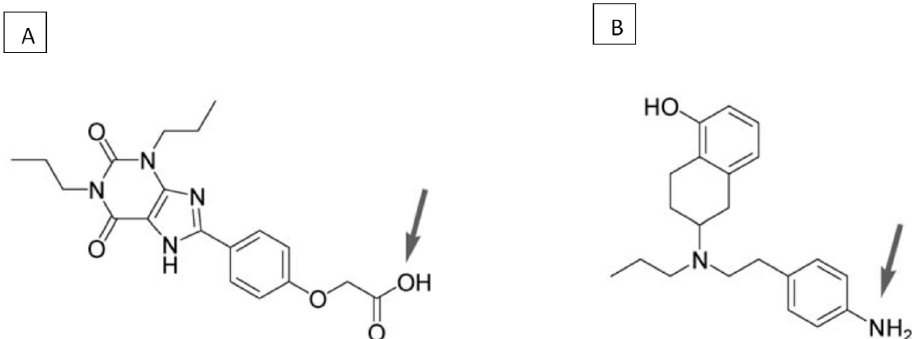
Figure 3. Chemical structures of the A 2A antagonist XCC ( A ) and the D 2 agonist PPHT-NH2 ( B ). By attaching a linker to the atomic positions indicated by the arrowheads, a bivalent ligand for A 2A R/D 2 R heteromers can be created [392].